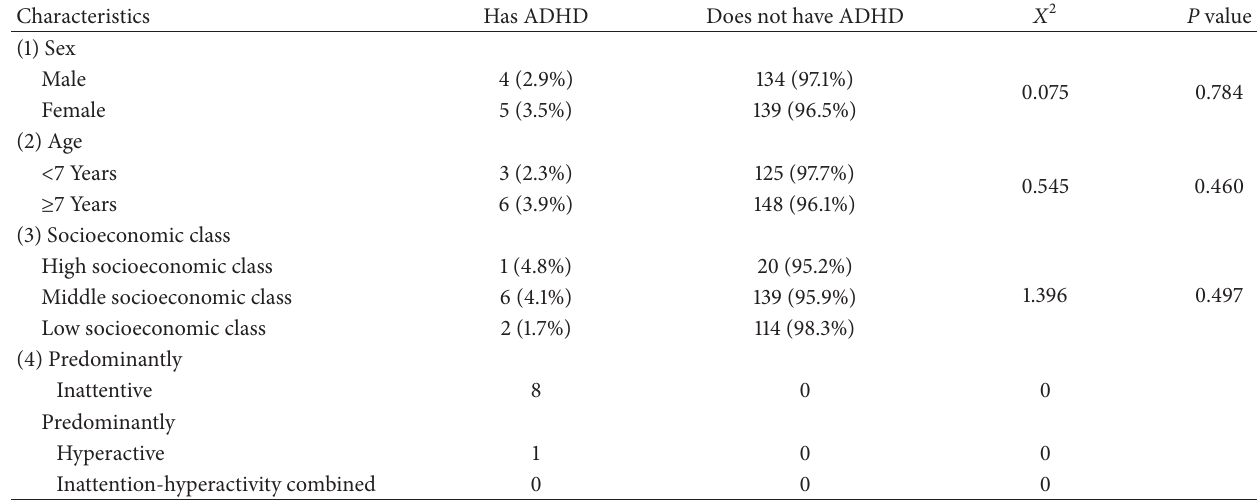
Table 2: Factors influencing ADHD.